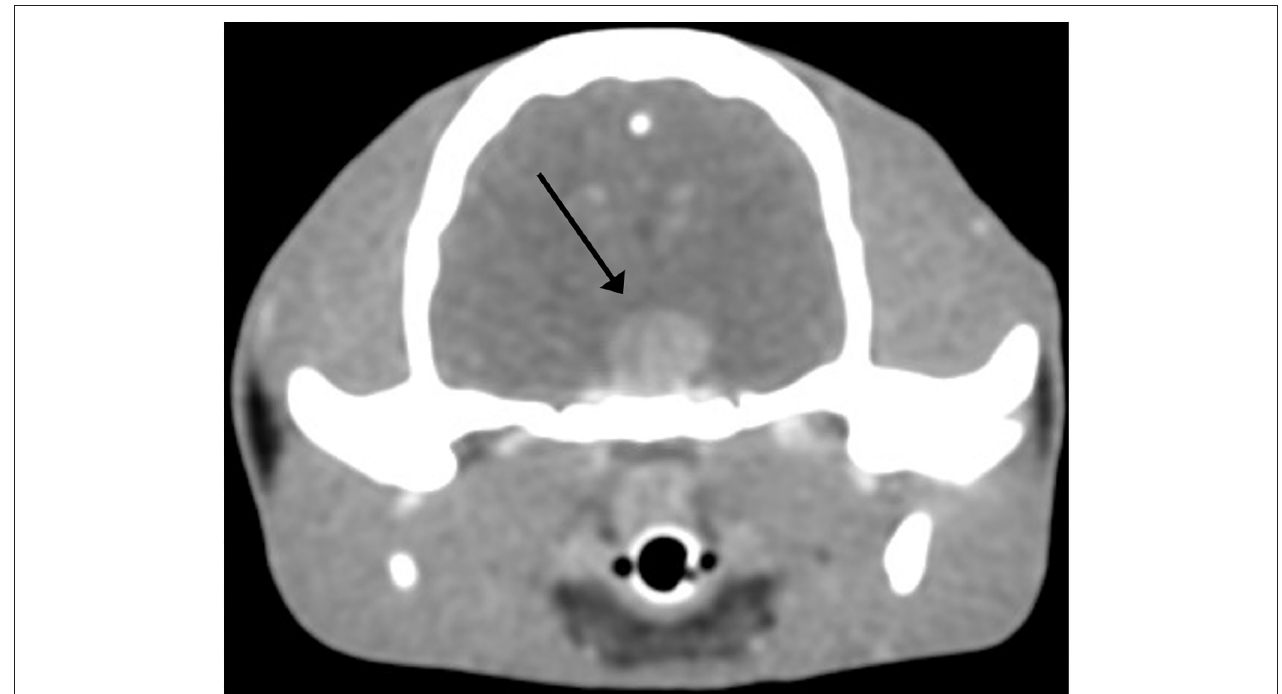
FIGURE 1 | Pituitary adenoma, cat. Postcontrast transverse CT image of the skull in soft tissue window. An 8.6 by 8.3 by 6.8mm mass (arrow) is noted at the anatomical region of the pituitary gland. A slice thickness of 0.62mm was